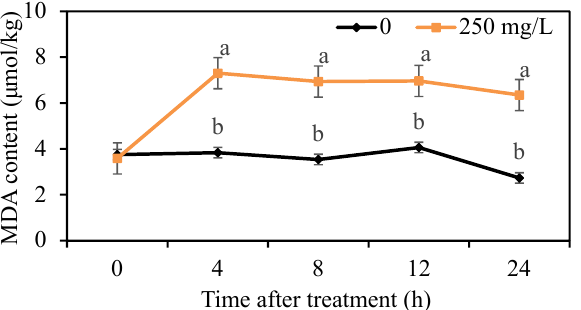
Figure 6. Effects of DMDC treatment on the MDA contents of G. citri-aurantii . The MDA content of G. citri-aurantii treated with 250 mg/L DMDC and untreated was determined at 0, 4, 8, 12, and 24 h. The data represent the mean ± standard deviation (SD). Different letters on each column represent significant differences ( p < 0.05 ) according to a t-test.